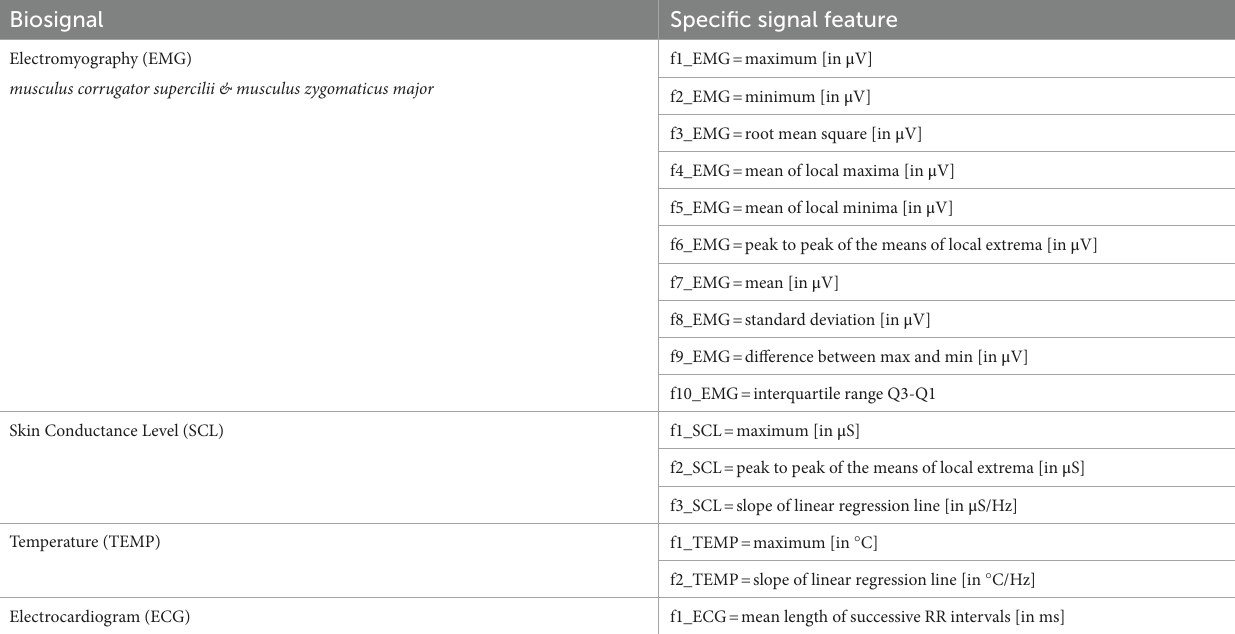
TABLE 1 Extracted features for each biosignal. Biosignal Specific signal feature Electromyography